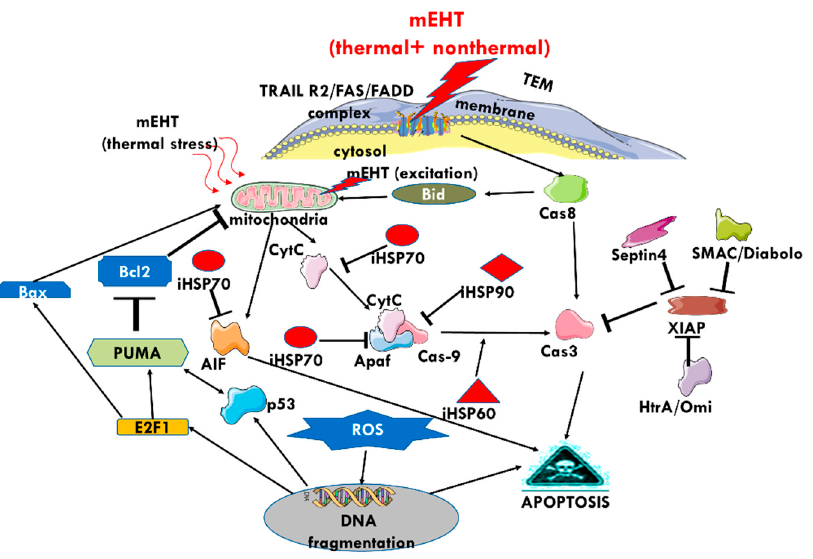
Figure 18. The multiple pathways involved in the apoptotic processes of cells after the thermal and nonthermal energy absorption of mEHT. The exhaustion of the protective mechanisms and the com- plex network of pathways ensures apoptosis as a final